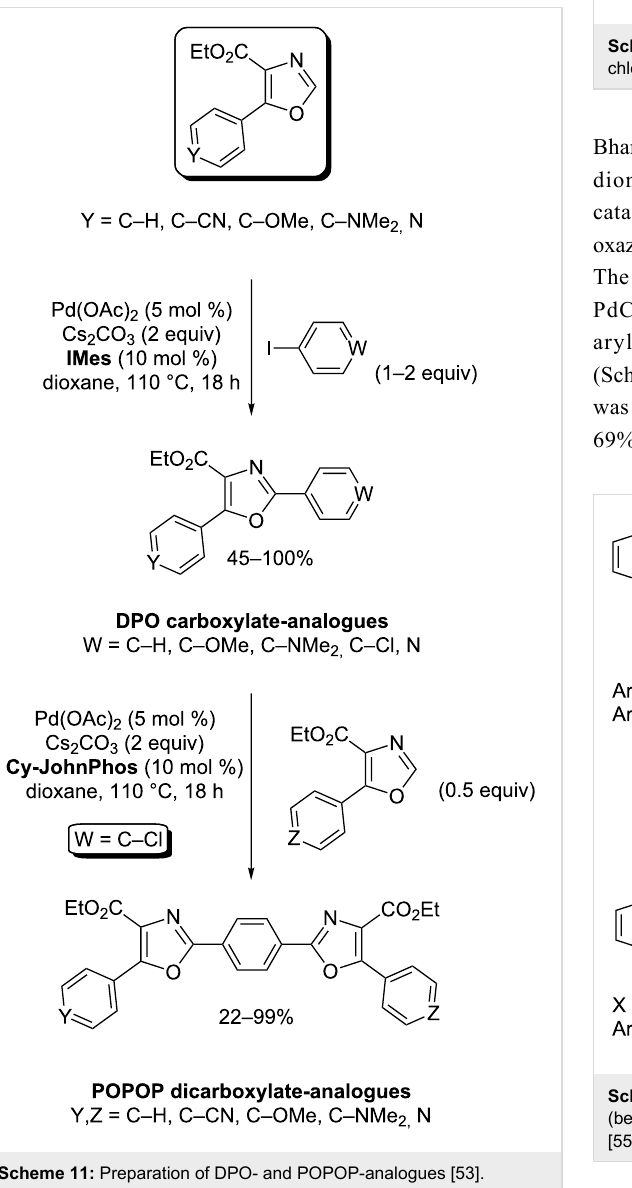
Daugulis used the bulky butyldi-1-adamantylphosphine asso- ciated with the potassium phosphate base to achieve Pd(0)- catalyzed direct arylation of various electron-rich heterocycles, including benzoxazole with aryl chlorides (Scheme 12) [54].